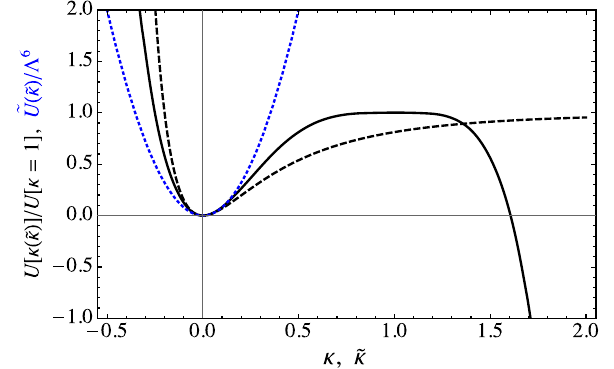
Fig. 1 Plot of the normalized π -frame action polynomial U (κ) as a function of the π -frame parameter κ (solid line) and the ρ -frame variable ˜ κ = κ/( 1 − κ) (dashed line) in d = 4. The blue dotted line depicts the ρ -frame action polynomial ˜ U ( ˜ κ)/(cid:3) 6